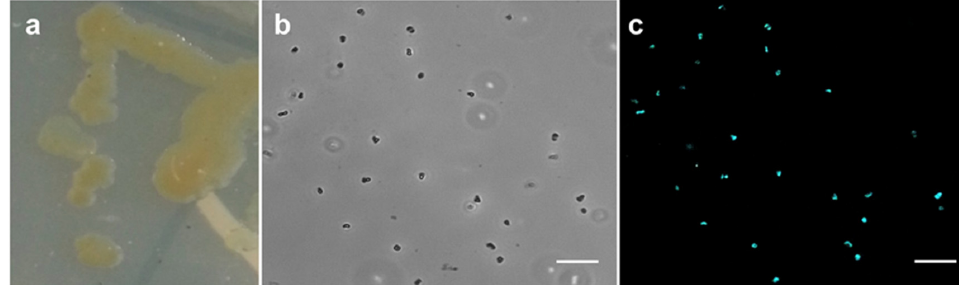
Figure 1. Morphology of methanogenic isolate E02.3. Colonies on MBA ( a ), cells visualized by phase contrast ( b ), and fluorescence microscopy ( c ); scale bars = 10 µm.